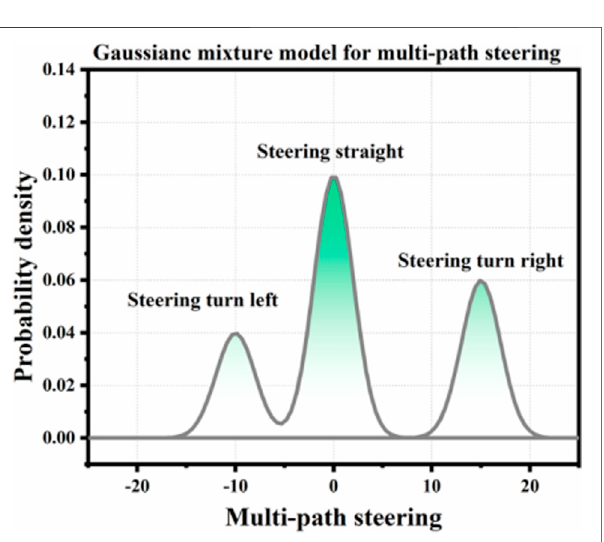
FIGURE 12 | Probability distribution of Gaussian mixture model corresponding to the steering angle.